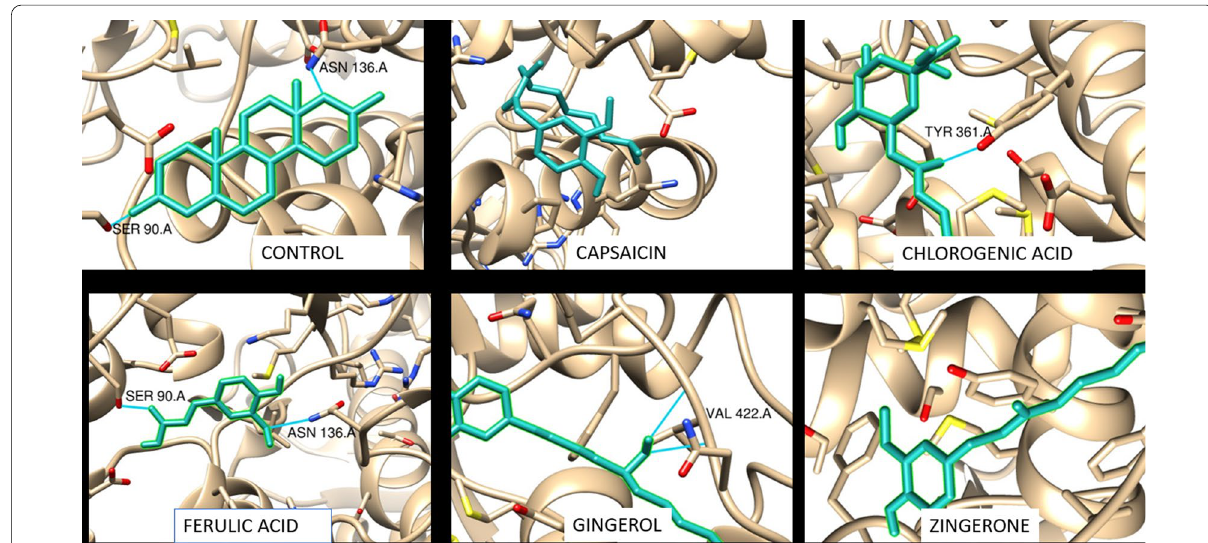
Fig. 7 Docked pictures of curcumin analogues and testolactone (control) against human aromatase receptor. (Ligand represents the blue sticks, hydrogen bond interaction is represented in blue line, receptor is represented in solid white ribbon